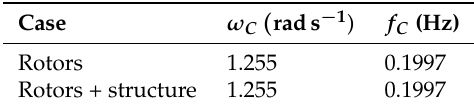
Table 4. Mean rotational frequencies of the rotors in each simulation